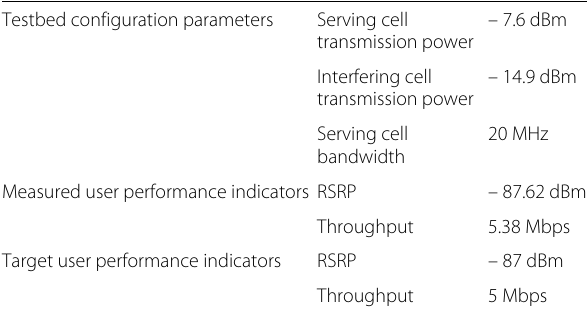
Table 2 Summary of the target values and the results obtained Testbed configuration